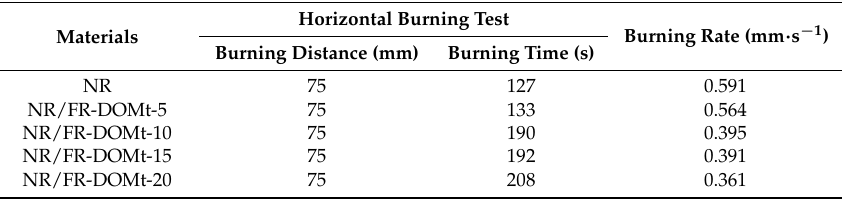
Table 4. Horizontal burning (HB) results of different NR nanocomposites.